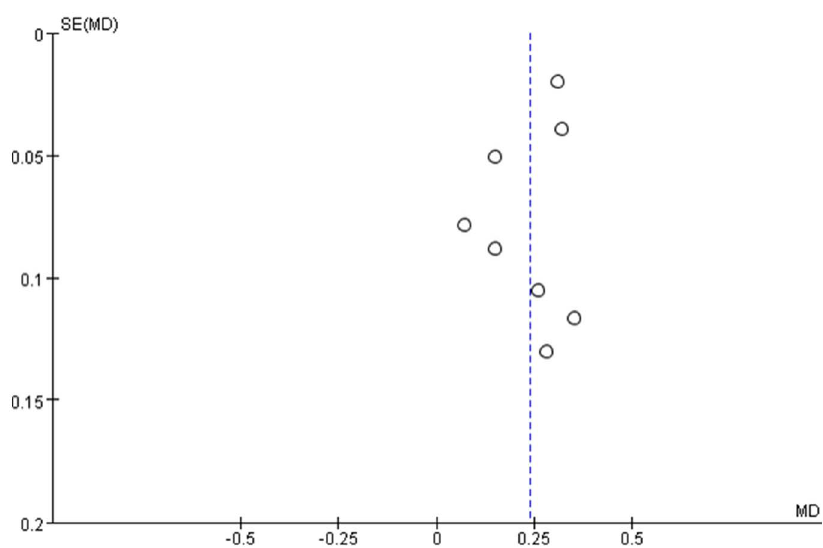
Figure 6. Funnel plot for the studies included to analysis the association between NSE concentration and unfavourable outcome in patients with traumatic brain injury.